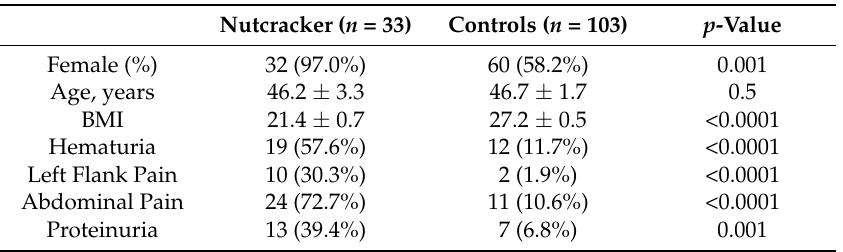
Table 1. Baseline patient characteristics and symptom presentation.